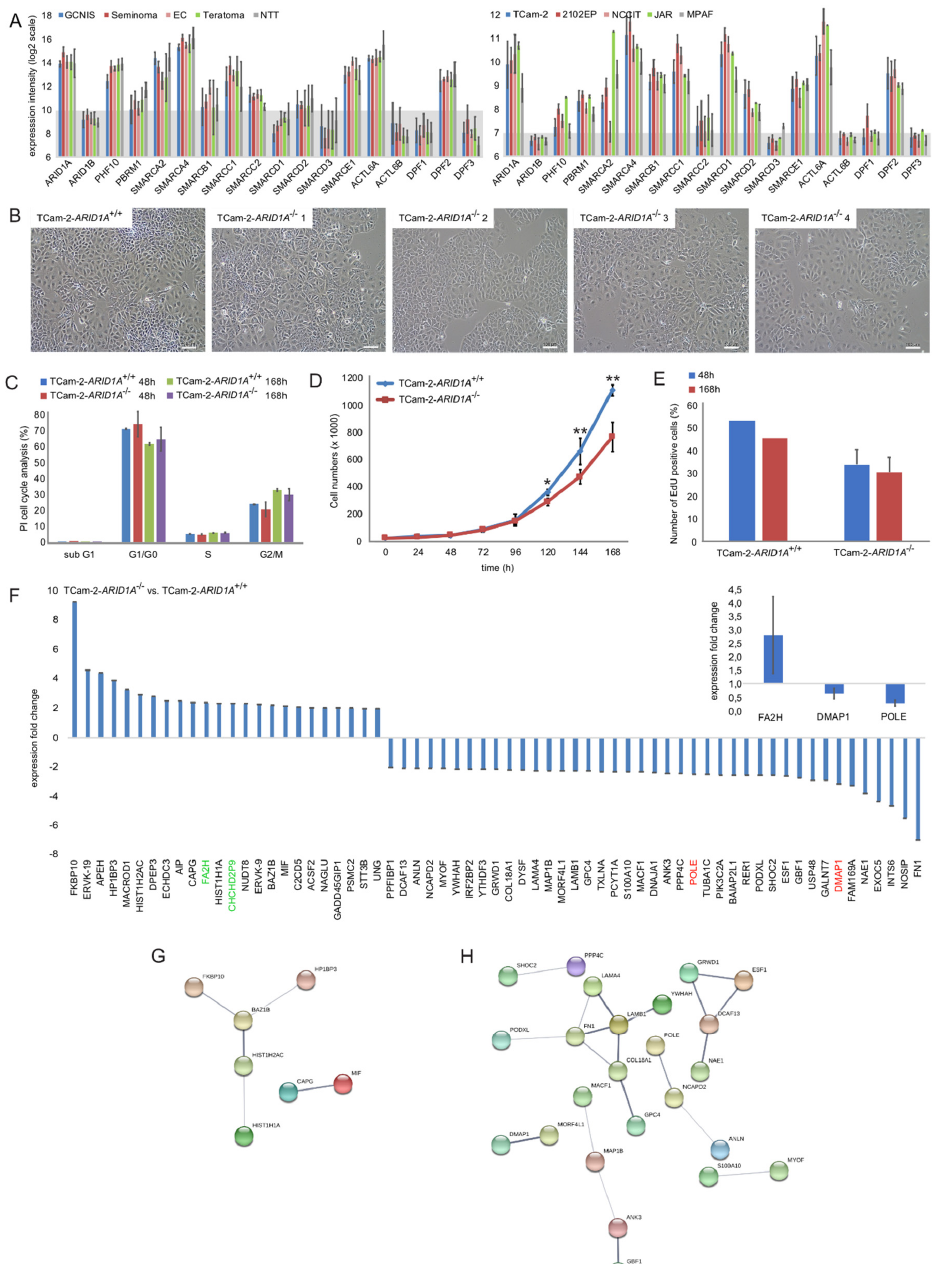
Figure 1. ( A ) Expression microarray data of SWI / SNF complex members in GCT tissues (left) and cell lines (right). Normal testis tissue (NTT) and fibroblasts (MPAF) were included as controls. Data were re-analyzed in context of this study. See ‘materials and method’-section for more details on expression microarray data. ( B ) Brightfield pictures of TCam-2- ARID1A +/+ and - ARID1A − / − cell morphology. Scale bar: 100 µ m. ( C ) Measurement of cell cycle phase distribution by PI-based flow cytometry in TCam-2- ARID1A +/+ and - ARID1A − / − cells. ( D ) Growth curves of TCam-2- ARID1A +/+ and - ARID1A − / − clones (average) over seven days. p -values * < 0.05, ** < 0.005. ( E ) EdU proliferation assay of TCam-2- ARID1A +/+ and - ARID1A − / − clones (average) after 48 and 168 h. ( F ) Mass spectrometry data of proteins enriched or depleted in TCam-2- ARID1A − / − versus - ARID1A +/+ cells. Inlay: A qRT-PCR analysis confirmed upregulation of FA2H and downregulation of DMAP1 and POLE . GAPDH was used as housekeeper and for data normalization. ( G , H ) STRING-based interaction prediction of enriched ( G ) or depleted ( H ) proteins in TCam-2- ARID1A − / − versus - ARID1A +/+